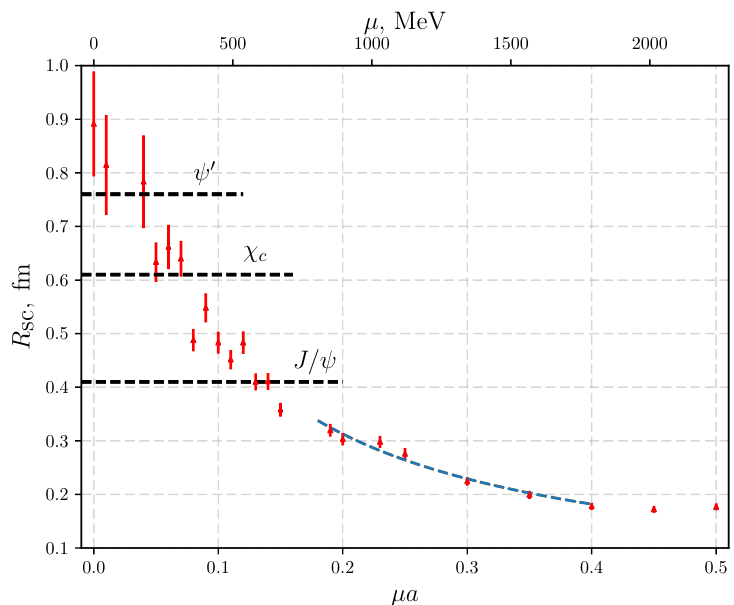
Figure 10 . The screening length calculated from equation (6.1) as a function of chemical potential. Black dashed lines represent mean squared radii blue dashed line is the description of the screening length R sc by the Debye screening formula